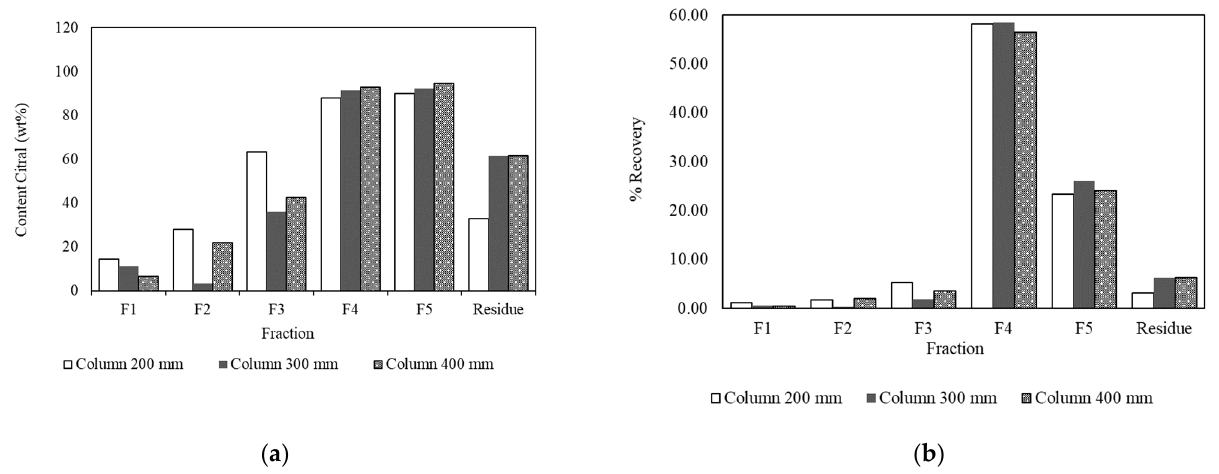
Figure 2. ( a ) Effect of distillation column on the content of citral in the fractions; ( b ) Effect of distillation column on the recovery of citral in the fractions.